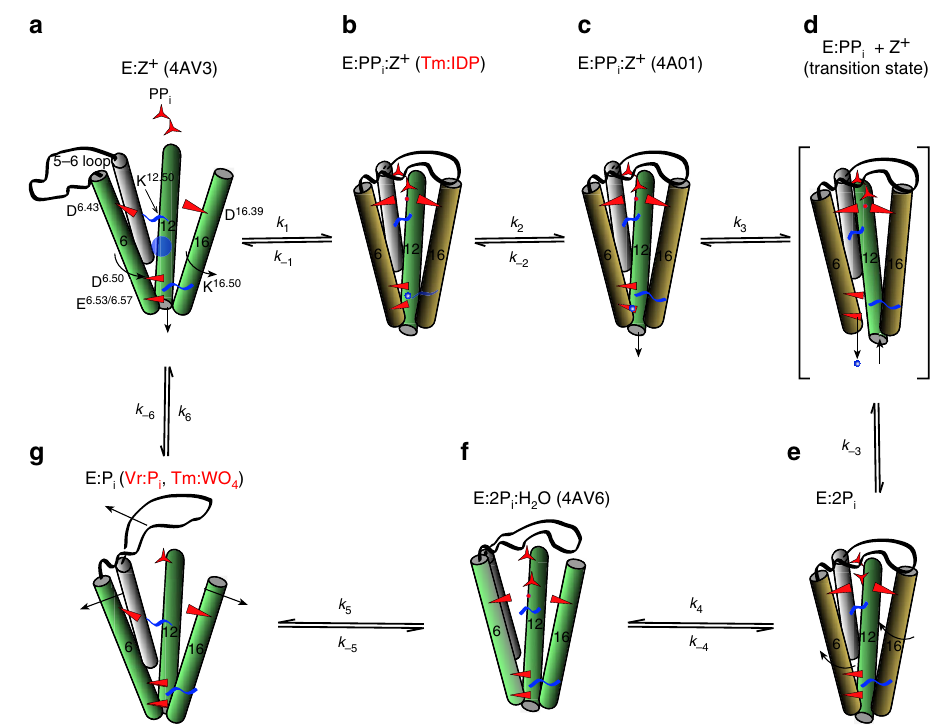
Figure 5 | Complete kinetic scheme of M-PPase catalytic cycle. ( a – g ) All the proposed conformational states of the M-PPase catalytic cycle are shown in order, including the transition state for pumping ( d ) and a ‘relaxed product’ state ( f ) analogous to yeast pyrophosphatase 46 . The structures used in the manuscript are shown, with the new structures marked in red; for the rest, the PDB code is shown. For clarity, only key helices involved in formation of the hydrolytic centre and ion channel are displayed. Aspartate and lysine residues are shown in red and blue respectively and labelled on state ( a ). Changes to helix position and rotation are denoted with arrows and by changes in the shading of the helices. The pumped ion (Na þ /H þ ) is represented as a blue sphere in states ( b – d ) and as a large blue sphere in state ( a ) to denote the unknown position of the pumped ion in the channel of the resting state. The nucleophilic water is represented as a red sphere in states ( b – d